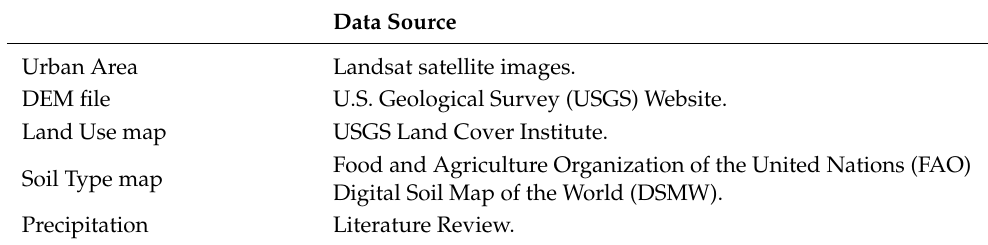
Table 1. Data used in flood simulation.